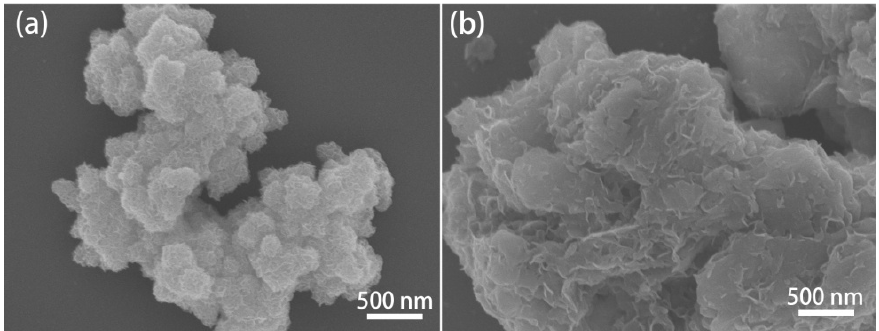
Figure 2. SEM images of ( a ) 1T-MoS 2 and ( b ) 1T-MoS 2 /PC. TEM and high-resolution transmission electron microscopy (HRTEM) images of the 1T-MoS 2 /PC are shown in Figure 3. The sample has a typical layered structure. The dark areas (Figure 3a) are composed of thick pelagic clay layers, while the flocculent substance with small contrast is a thinner MoS 2 sheet. A well-stacked layered structure with a lattice spacing of 0.62 nm is evidently visualized in Figure 3b, corresponding to the (002) crystal plane of 1T-MoS 2 . This is solid evidence for the presence of MoS 2 [1]. Energy dispersive spectroscopy (EDS) confirmed this result. As displayed in Figure 3c–f, the thicker areas of the sample contain mainly Si and Al, which are the major components of the pelagic clay minerals. The surrounding flocculent substance contains mainly S and Mo, suggesting that these areas are mainly MoS 2 . This result also proves the composite structure of MoS 2 and pelagic clay.